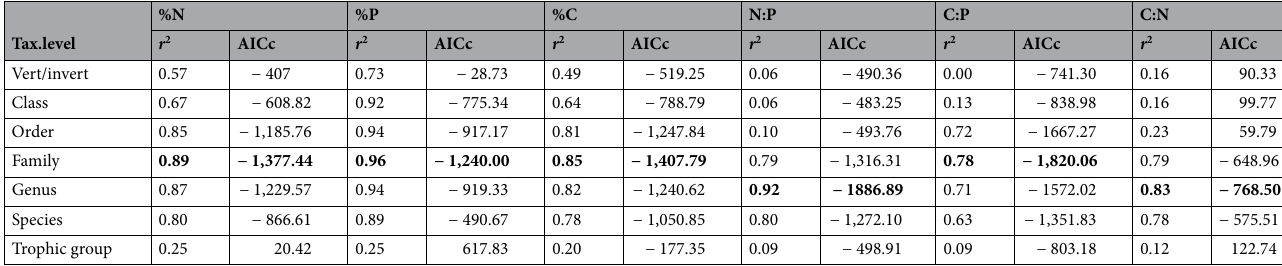
Table 1. Model comparisons of the relative ability of taxonomic levels (species, genus, family, and class), invertebrate/vertebrate category, and trophic groups to explain diffence in body nutrient content of organisms. Bold text indicates models with the best r 2 and AICc.